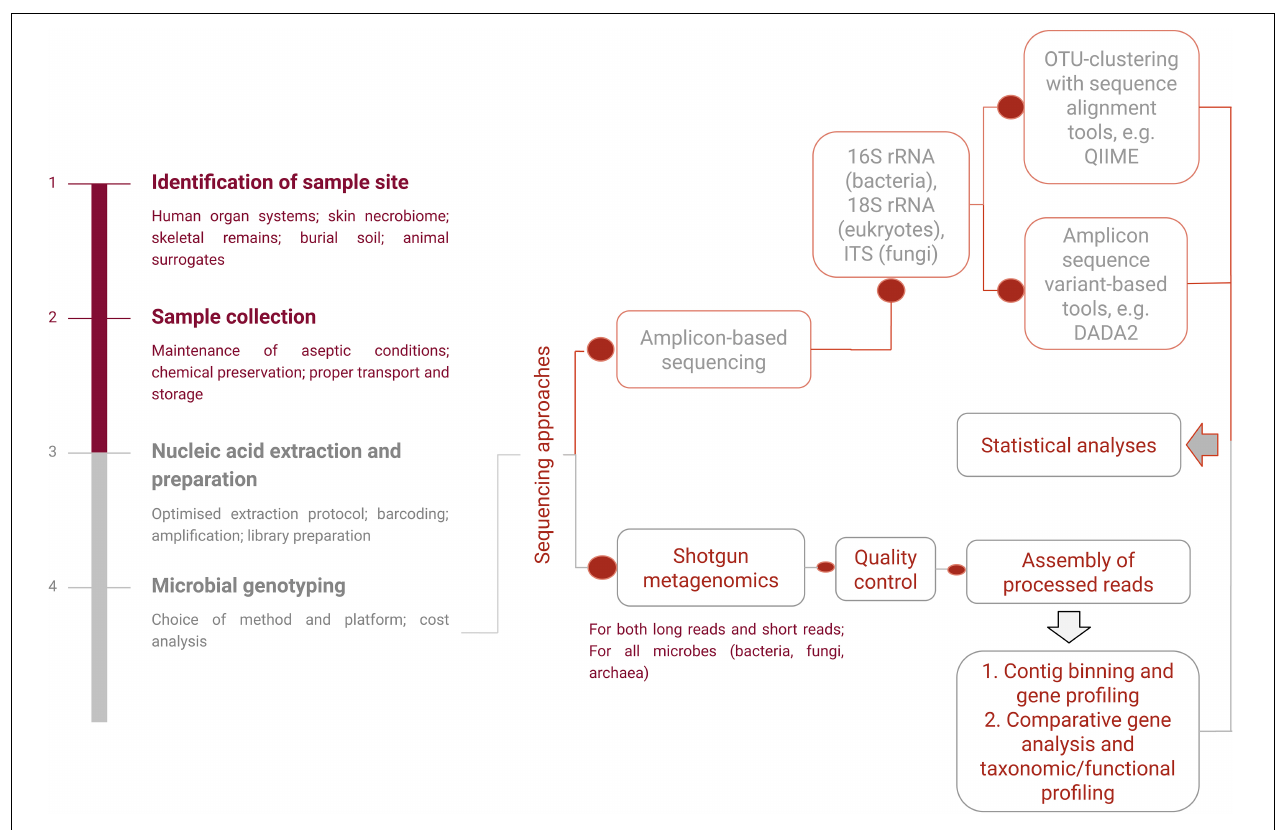
FIGURE 3 | A schematic representation of amplicon-based and shotgun metagenomic sequencing